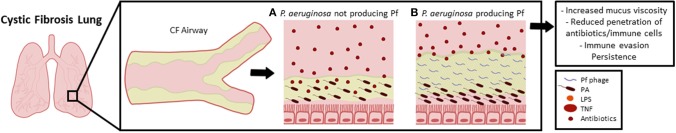
Pf phages contribute to the pathogenesis of Pa airway infections in CF. The thick mucus coating the airways in a CF lung facilitates colonization with Pa and other bacterial pathogens. Even in the absence of Pf phages, Pa forms tenacious biofilms which protect bacterial cells from phagosomal clearance and resist penetration by antibiotics (A). However, Pf phages when present organize the polymer-rich biofilm into crystalline, higher order structures (B), This drives sputum viscosity, adhesiveness, and resistance to desiccation. It also enhances the antibiotic tolerance and immune evasion of bacterial colonies within biofilms, thereby contributing to increased bacterial burden. In this way Pf phages enhance the pathogenesis of Pa airway infections in CF.